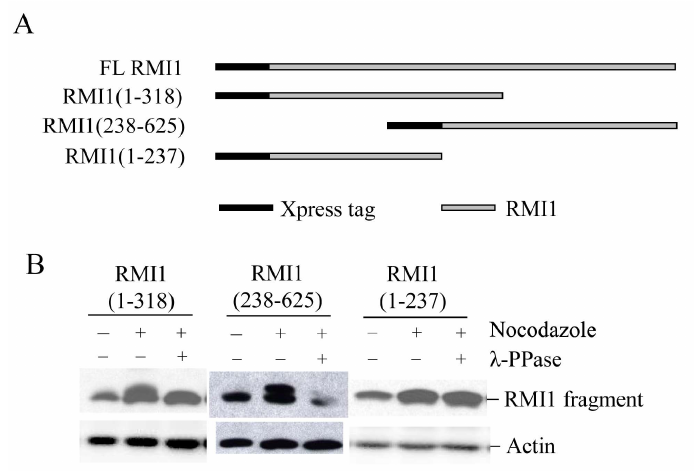
Figure 3. Mapping RMI1 mitotic phosphorylation sites. ( A ) Schematic representation of full-length (FL) Xpress-RMI1 and truncated fragments; ( B ) 293T cells were transfected with the constructs shown above. Thirty-two hours later, cells were treated with nocodazole or not for 16 h prior to harvest. Extracted proteins were treated with λ -phosphatase or not as shown, then resolved by 8% polyacrylamide gel and blotted with anti-Xpress